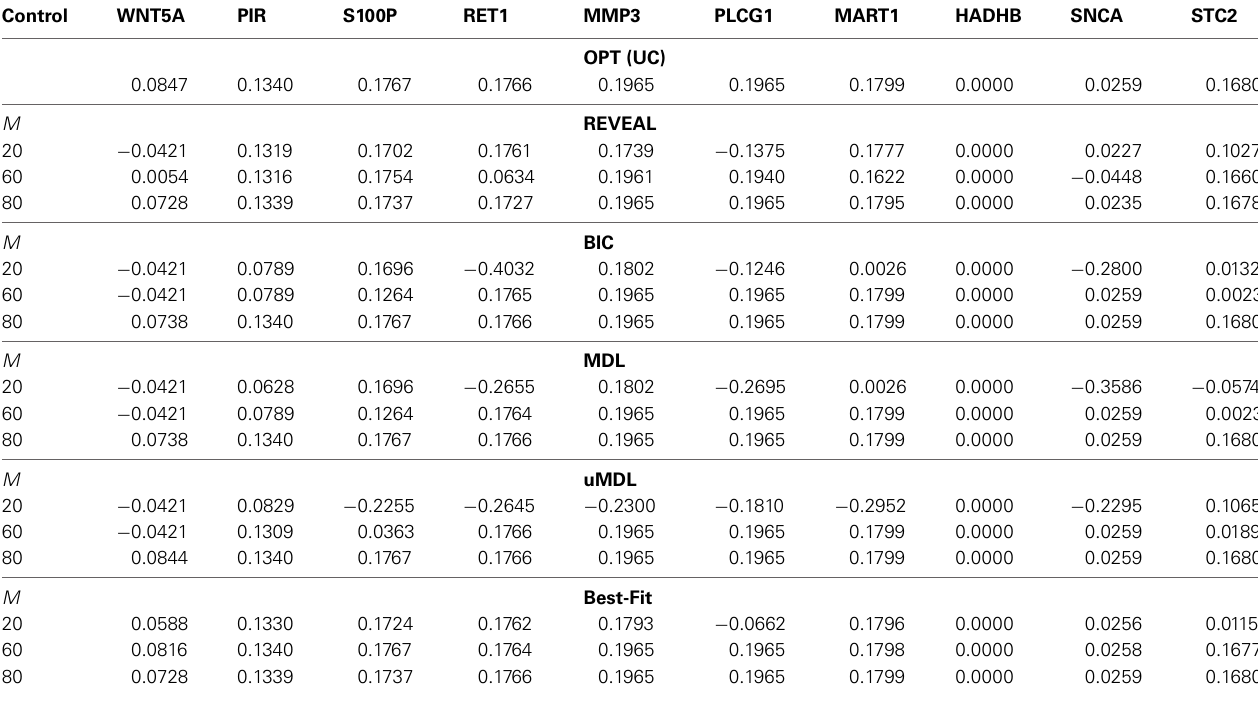
Table 3 | The shifted undesirable steady-state mass in the metastatic melanoma network by the MSSA algorithm for different control genes derived on inferred networks from five network inference algorithms (REVEAL, BIC, MDL, uMDL, and Best-Fit) with M = [ 20 , 60 , 80 ] different number of observed state transitions, compared to the optimal shift by applying the MSSA algorithm to the original network.